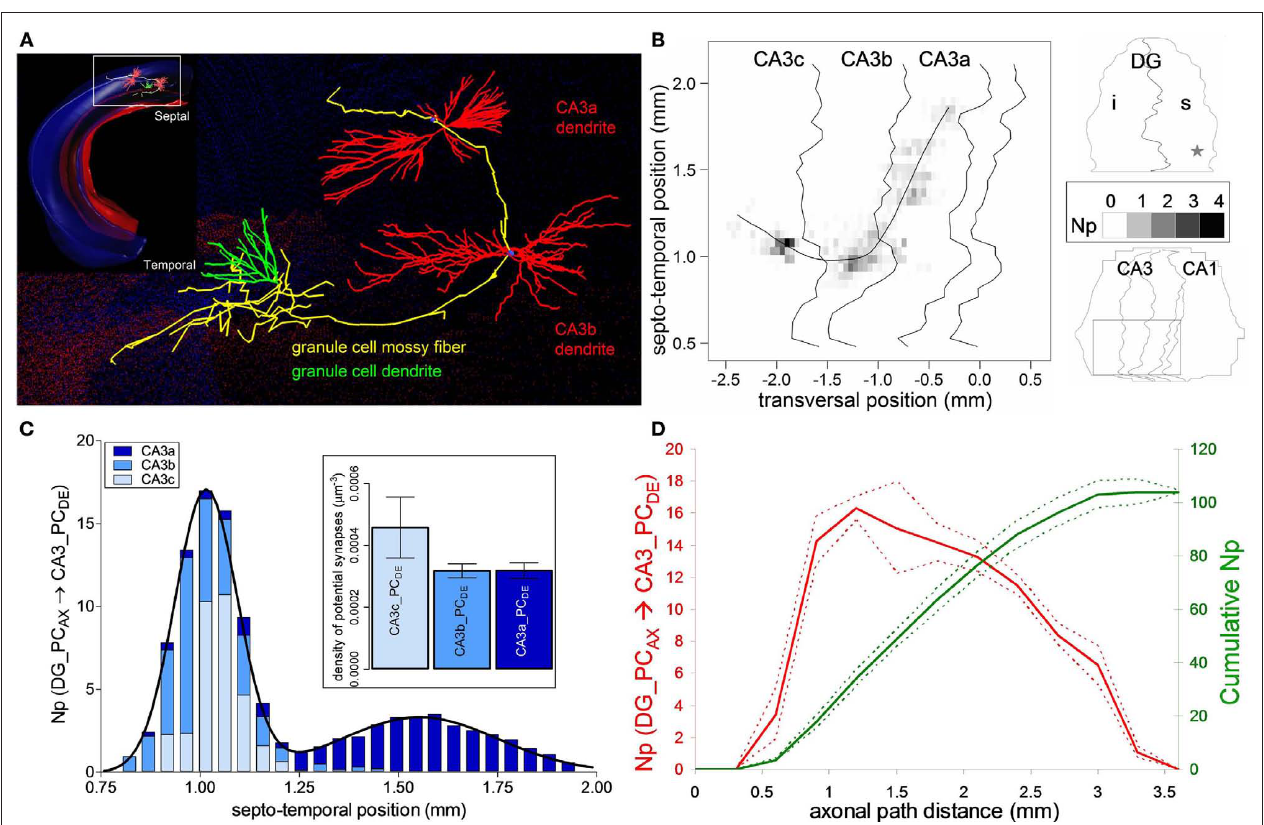
the axon (square box), corresponding to the main panel. The fitting line is a cubic spline function ( r 2 = 0.85) of septo-temporal vs. transversal positions weight- averaged by the potential synapse numbers. (C) Average number of potential contacts in each of the CA3 sub-regions, fitted with two Gaussian curves. Inset shows the density of potential synapses. (D) Number (left axis, red) and cumulative count (right axis, green) of potential synapses along axonal path distance. The solid and dashed colored lines correspond to averages and 95% confidence interval around